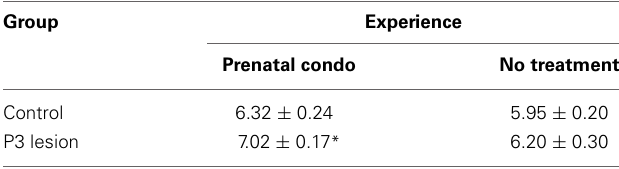
Table 6 | Summary of spine density on the apical terminal. Group